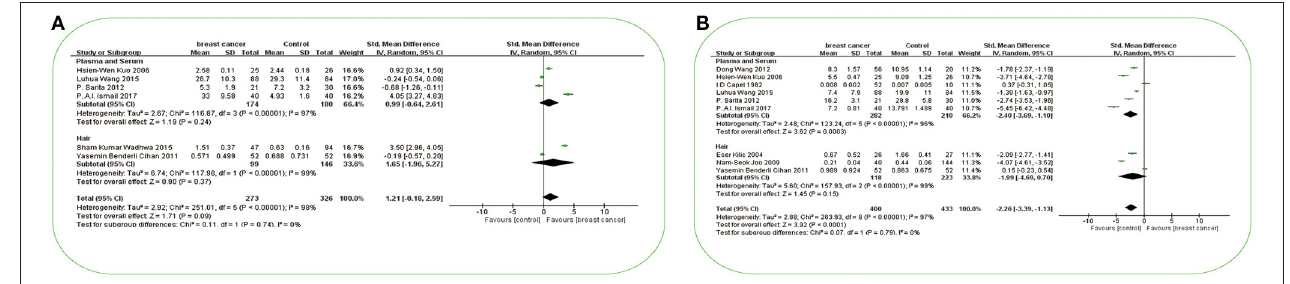
FIGURE 4 | Forest plot of studies of possible essential trace elements in subjects with breast cancer vs. non-breast cancer controls. (A) Forest plot of studies of Ni levels in subjects with breast cancer vs. non-breast cancer controls. (B) Forest plot of studies of Mn levels in subjects with breast cancer vs. non-breast cancer controls. The standard mean differences (SMD) and 95% confidence intervals (CIs) were calculated using the random-effects model. Ni, nickel; Mn,